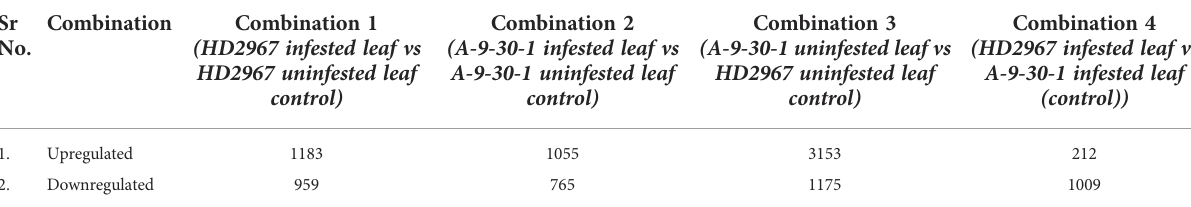
TABLE 2 DGE summary of the four combinations. Sr Combination No.